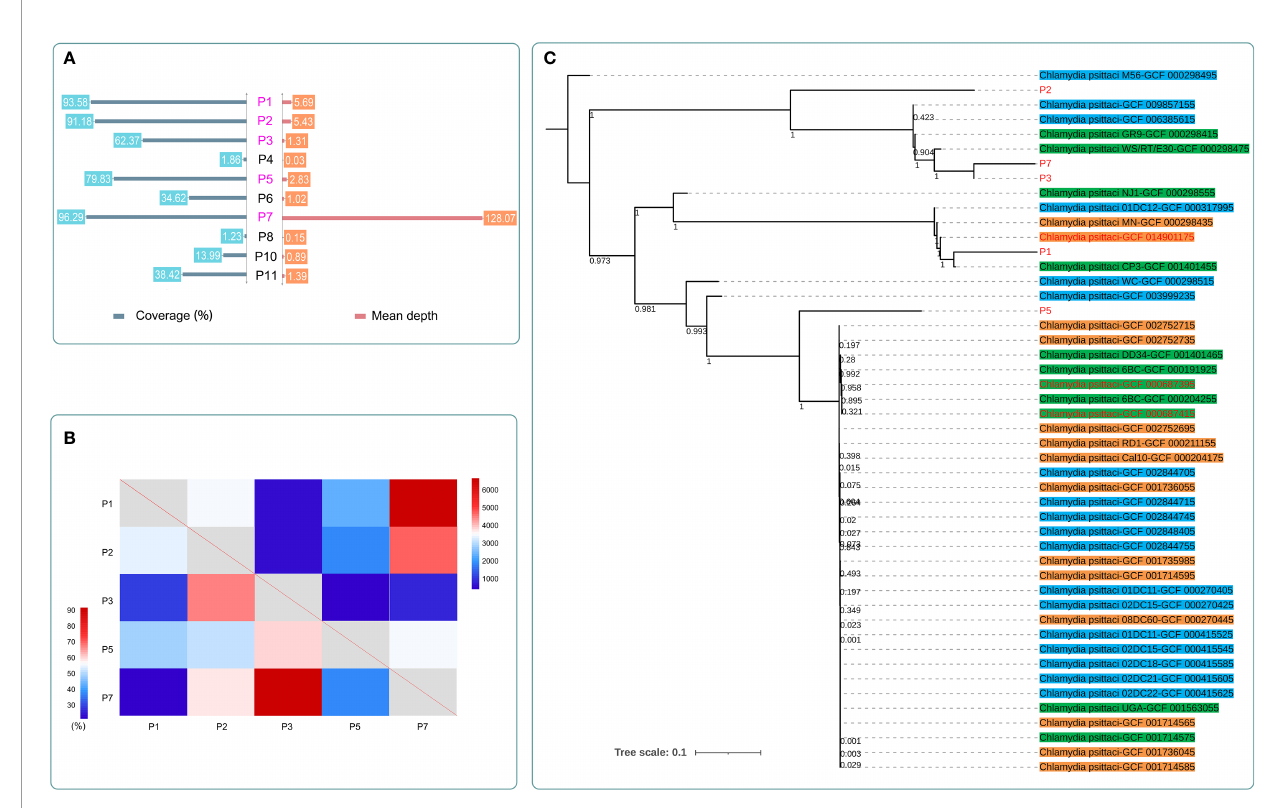
FIGURE 5 | The detection results after whole-genome capture and the maximum-likelihood phylogenetic tree of C. psittaci in this study. (A) The coverage and mean depth of 10 samples after capture. The data of C. psittaci in fi ve cases (marked in purple) with coverage >60% and mean depth >1 were further analyzed. (B) The detected SNP number (top right) and the shared variation percentage (bottom left) of each paired samples after capture. P3 and P7 showed the closest genetic relationship among the fi ve samples; they shared the same variations in 92% of 856 SNPs. (C) The maximum-likelihood phylogenetic tree of C . psittaci. Samples marked in red were from China. Samples highlighted in green were isolated from birds. Samples highlighted in blue were isolated from mammals. Samples highlighted in orange were isolated from